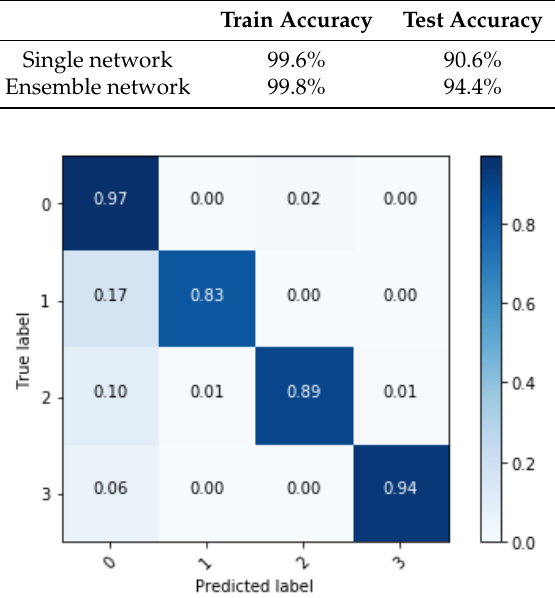
Figure 9. Confusion matrix of classification results from the single